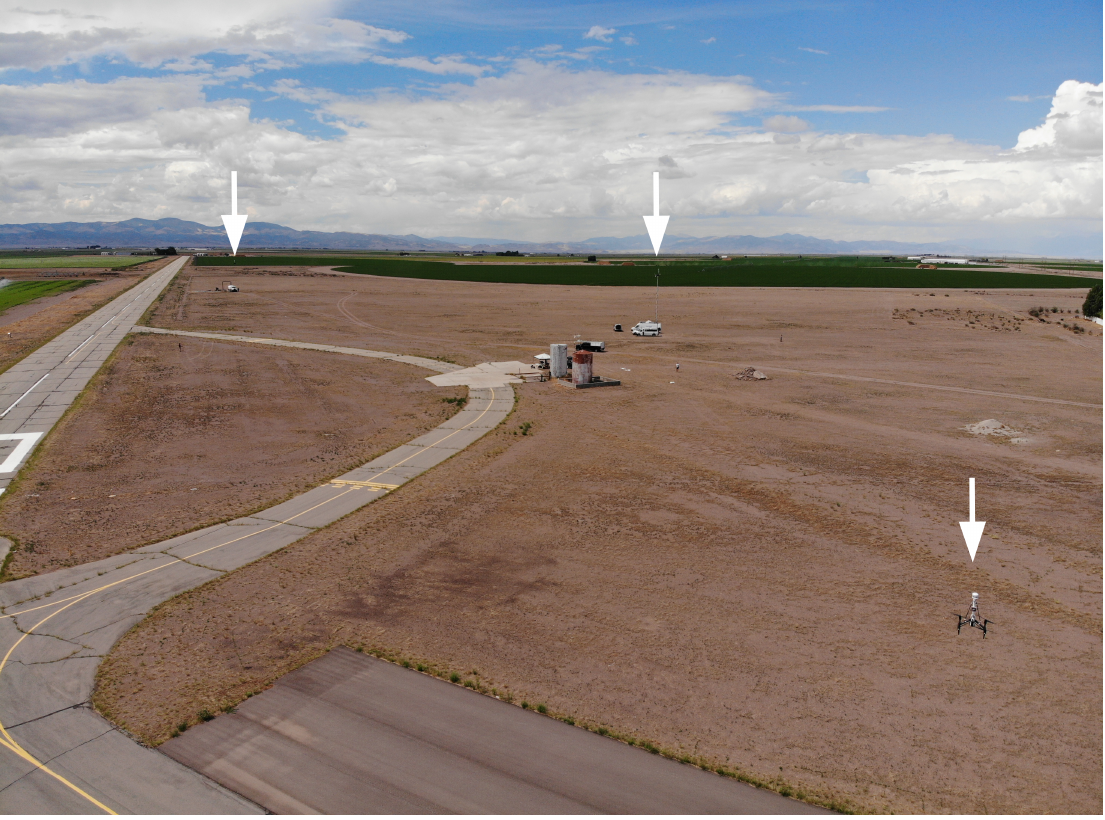
Figure 4. Simultaneous flights with sensors in a triangle formation (white arrows). Both UASs were operating off of marks on the taxiway, and the MURC tower was stationed north of the UAS